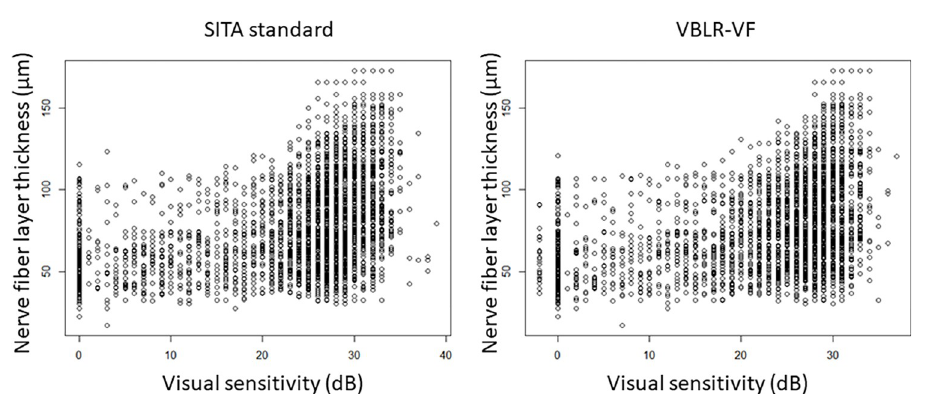
Fig 2. Relationship between visual sensitivity and cpRNFL (whole visual field). The relationship between visual sensitivity and cpRNFL in whole visual field is shown. cpRNFL, circumpapillary retinal nerve fiber layer, SITA, Swedish interactive thresholding algorithm; VBLR, variational Bayes linear regression; VF, visual field.